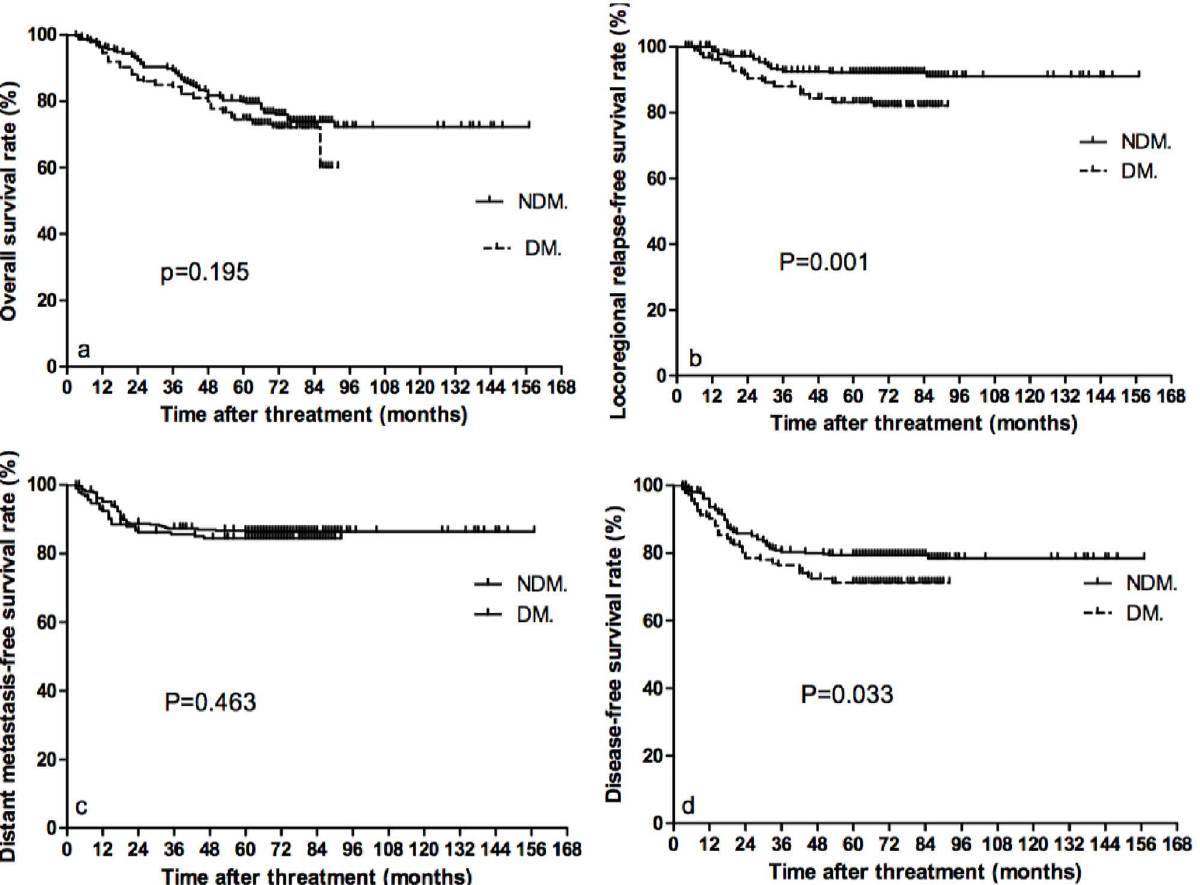
Fig 1. Kaplan–Meier estimates of the survival of the two groups in NDM and DM. (a) overall survival; (b) locoregional relapse-free survival; (c) distant metastasis-free survival; (d) disease-free survival